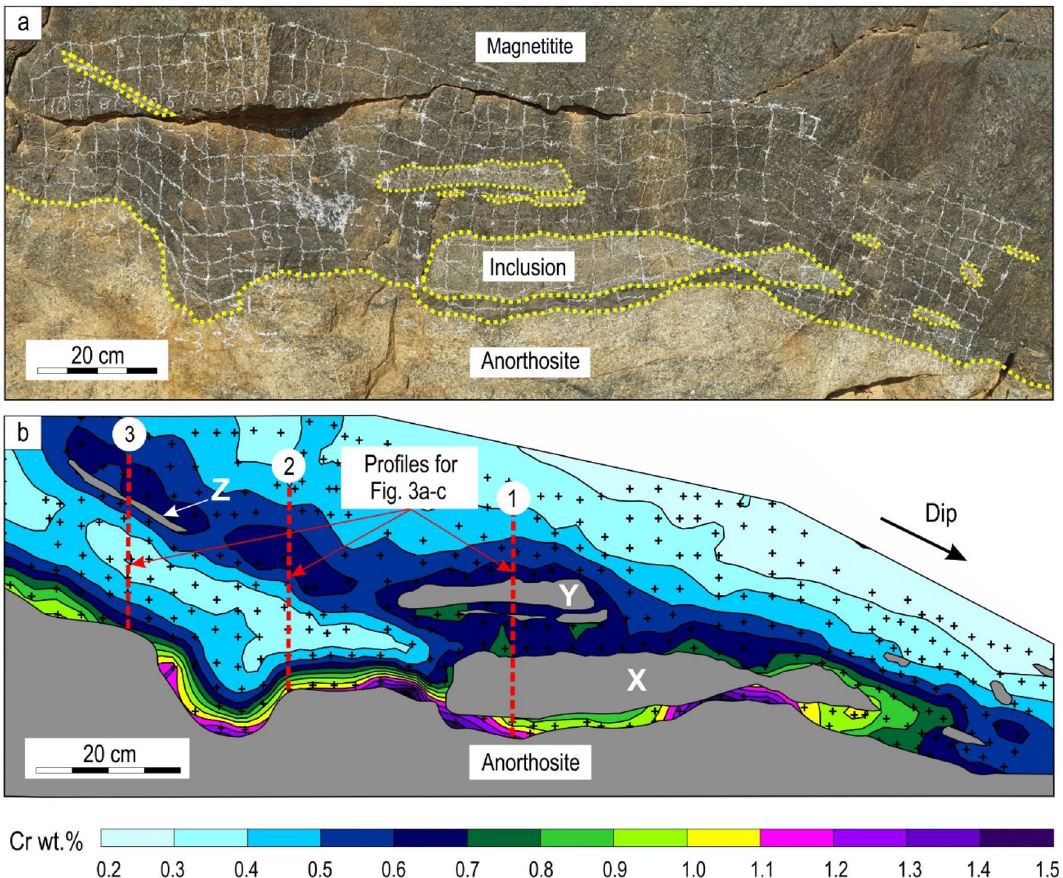
Figure 1. Massive magnetitite with two-dimensional Cr chemical patterns. (a) Field photograph of an outcrop of the bottom seam of massive magnetitite showing undulated footwall contact and several anorthositic inclusions; (b) Geochemical contour map showing the distribution of Cr within the layer. Crosses indicate individual analysis points. Overall, the Cr concentration decreases rapidly upwards in the layer. Higher Cr contents were recorded at the basal contact and around anorthositic inclusions, including a cryptic zone with higher Cr contents connecting the central inclusion Y and a smaller one Z to the left. A converging chemical pattern is observed between this cryptic zone and the floor. Several dome-shaped high Cr growth nodes on the bottom contact of the layer indicate incipient in situ nucleation and growth of magnetitite 35,52 . Two-dimensional geochemical mapping of this outcrop is done using a handheld X-ray fluorescence spectrometer (pXRF). Black crosses indicate the positions of individual data points. The pXRF data can be found in Supplementary Information Table 1. Figure 1b is created using Surfer software (version 9.2.397). The outcrop is located at the Rhovan Mine, Western Bushveld Complex, South